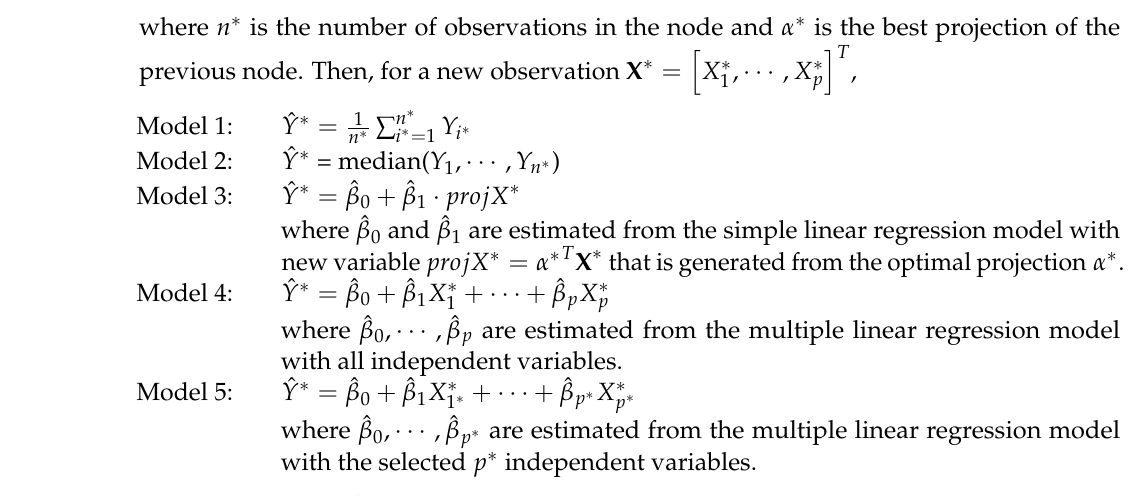
Table 1. MSEs of the toy example with lm , randomForest , rpart , and the projection pursuit regression tree.